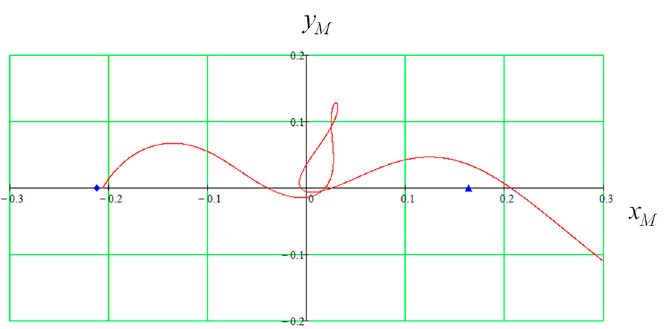
Figure 21. The trajectory of the SC motion corresponding to the “circumlunar” area; built in a rotating selenocentric coordinate system, the main direction of which coincides with the direction of the Moon-Earth axis. The blue rhombus shows the position of the libration point L 2 , the blue triangle shows the position of the point L 1 .